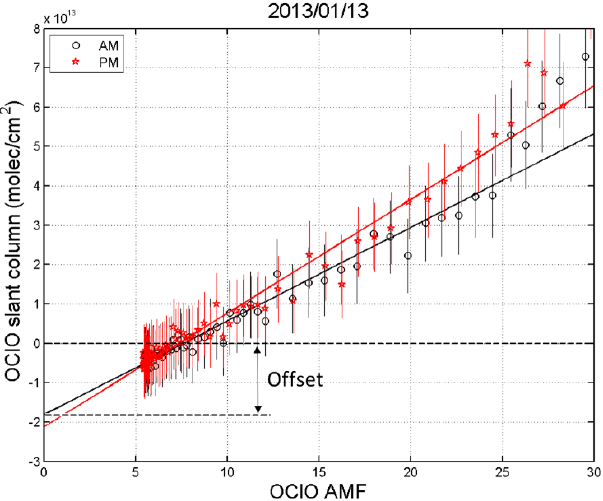
Figure 5. Illustration of the Langley plot method used to estimate offset artifacts on OClO SCD measurements. This case was ob- tained in Harestua on 13 January